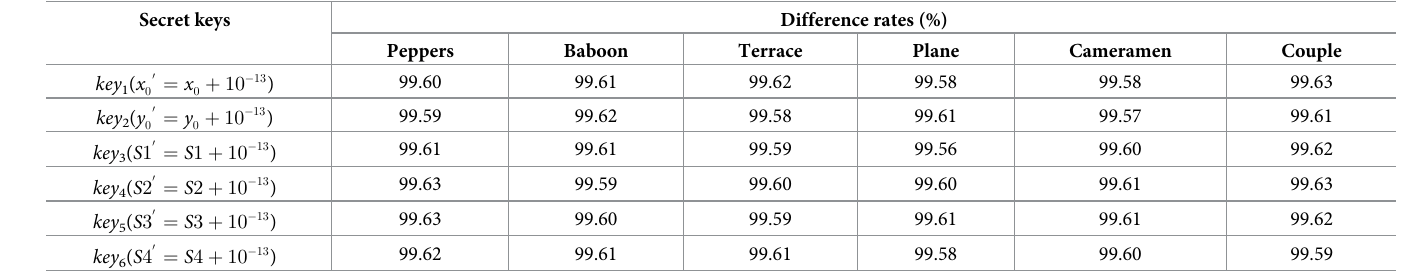
Table 9. Difference rates between two images encrypted by slightly different keys.